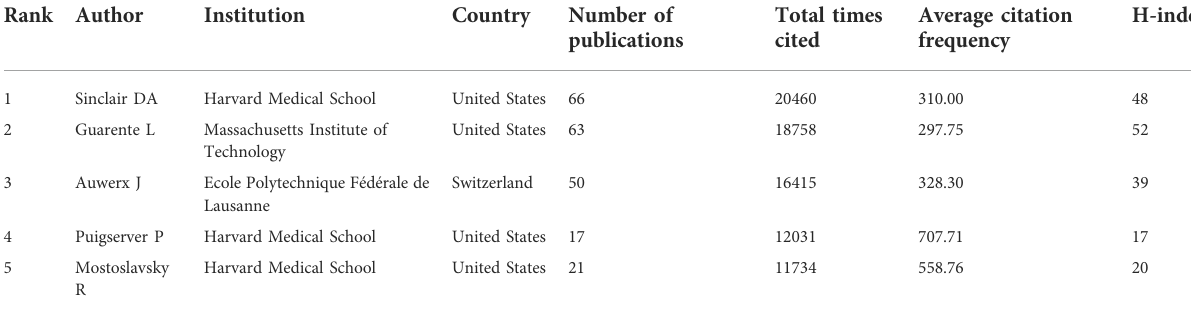
TABLE 4 The top fi ve most cited authors for the study of